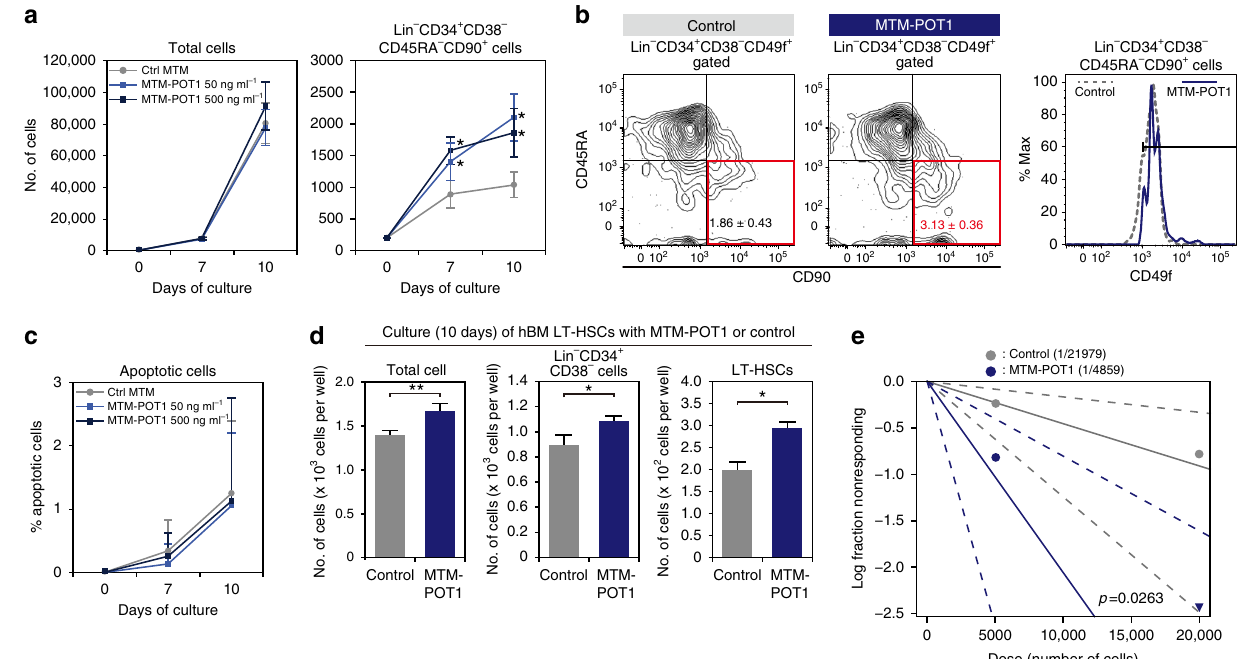
Fig. 10 POT1 maintains self-renewal activity of human HSCs. hCB-derived LT-HSCs (200 cells per well) were cultured for 10 days with or without MTM-POT1. a Number of total cells ( left ) and Lin – CD34 + CD38 − CD45RA − CD90 + cells on day 7 and 10 of culture. Data are expressed as the mean ± SD ( n = 10, * p < 0.01 by t -test). b Representative FACS pro fi les of CD90 and CD45RA in Lin – CD34 + CD38 – CD49f + cells ( left ) and the expression of CD49f in the Lin – CD34 + CD38 − CD45RA − CD90 + fraction ( right ). c Percentage of Annexin V + PI + apoptotic cells in Lin – CD34 + CD38 − CD45RA − CD90 + cells on day 7 and 10 of culture. Data are expressed as the mean ± SD ( n = 11: day 7, n = 9: day 10). d LT-HSCs isolated from hBM (200 cells per well) were cultured for 10 days with or without MTM-POT1 (50 ng ml – 1 ). Number of total cells, CD34 + CD38 − cells, and LT-HSCs after culture are shown. Data are expressed as the mean ± SD ( n = 3, * p < 0.01, ** p < 0.05 by t -test). Representative data from two independent experiments are shown. e Result of limiting dilution BMT. A log-fraction plot of the limiting dilution model is shown. The slope of the line is the log-active cell fraction. The dotted lines give 95% con fi dence intervals ( n = 5). The data point with zero negative response at dose 20,000 is represented by a downward-pointing triangle. Estimated numbers of repopulating cells are also